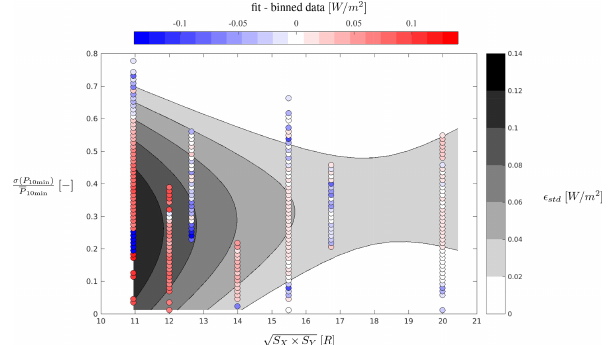
Figure 9. Contours based on multiple linear regression fit of bin- averaged power production per area to the standard deviation of power production normalized by mean power production and rel- ative turbine spacing. Points mark the binned data, where blue and red shades indicates whether the fit underestimates or overestimates, respectively, the binned averaged values.